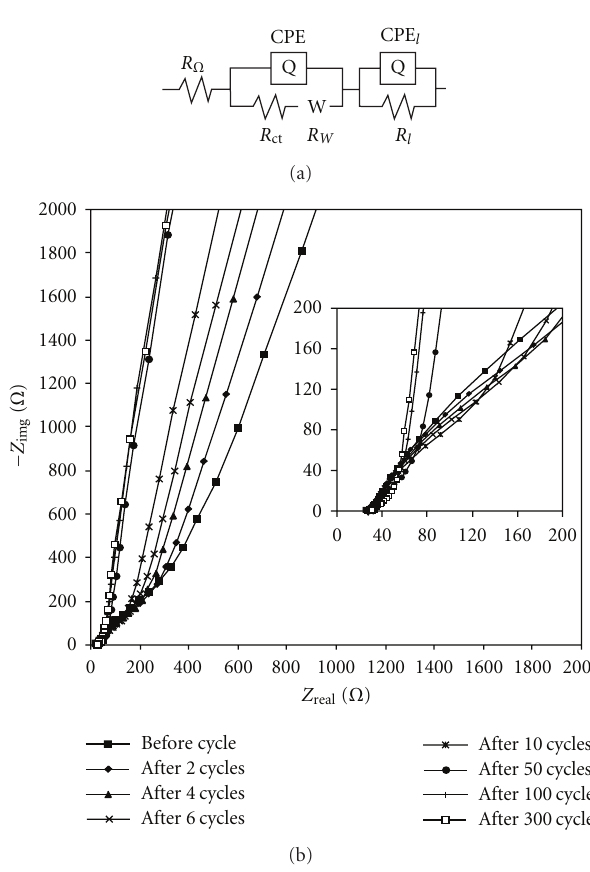
Figure 3: (a) Cyclic voltammograms of MnO 2 thin-film EC prototypes evaluated in 0.2 M Na 2 SO 4 aqueous electrolyte cycled for up to 300 cycles, and (b) specific capacitance of MnO 2 thin-film EC prototypes (F/g) as a function of cycle number.